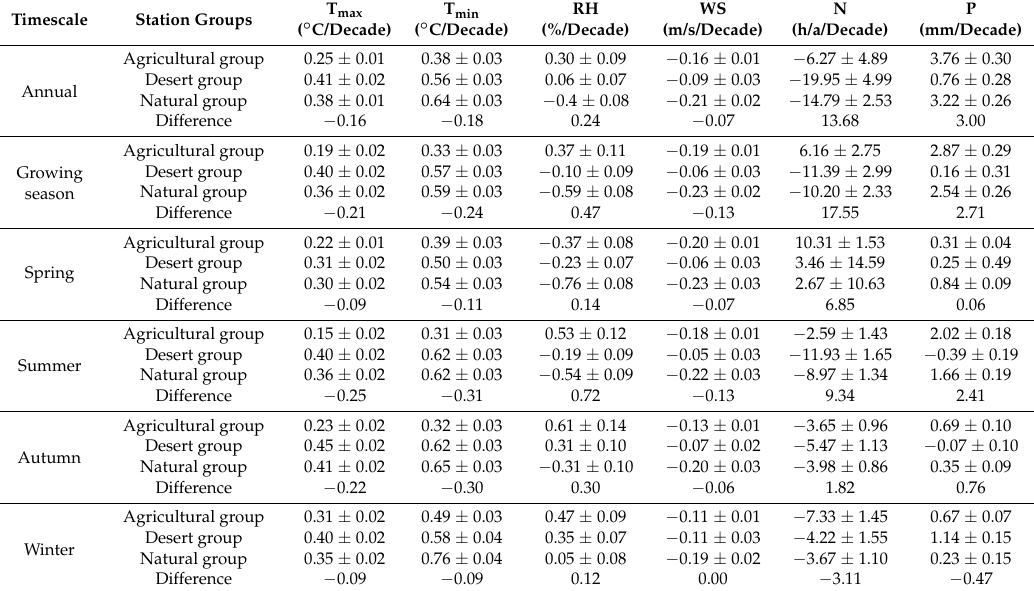
Table 5. Trend magnitudes in annual and seasonal meteorological factors in the different station groups,